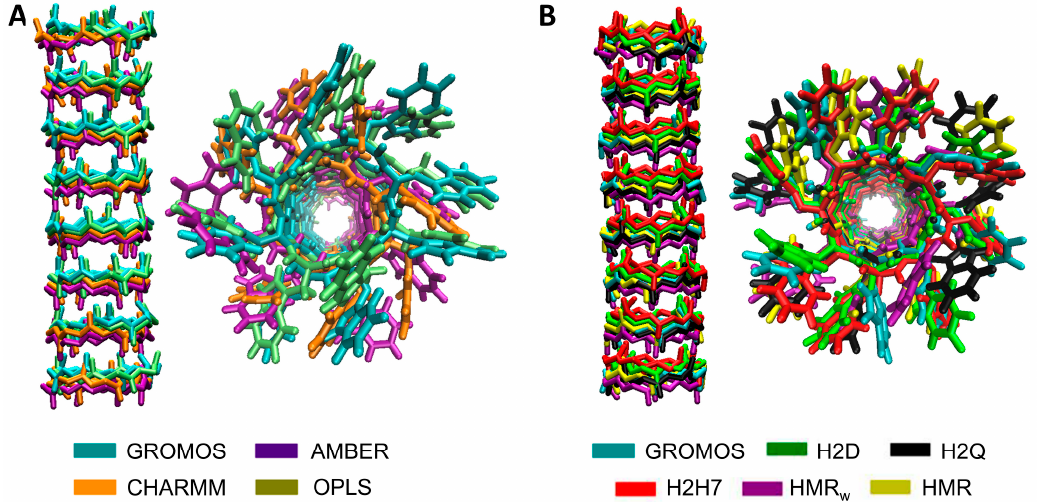
Figure 2. Lateral- and top-view structure alignment of the last snapshot (t = 300 ns) of the SCPN simulated with different classical force fields ( A ) and the GROMOS-modified force fields ( B ). For simplicity, only the backbone is shown for the lateral representation. Each color represents a different force field or force field parameterization. The classical GROMOS force field is included in both ( A , B ) as a reference.